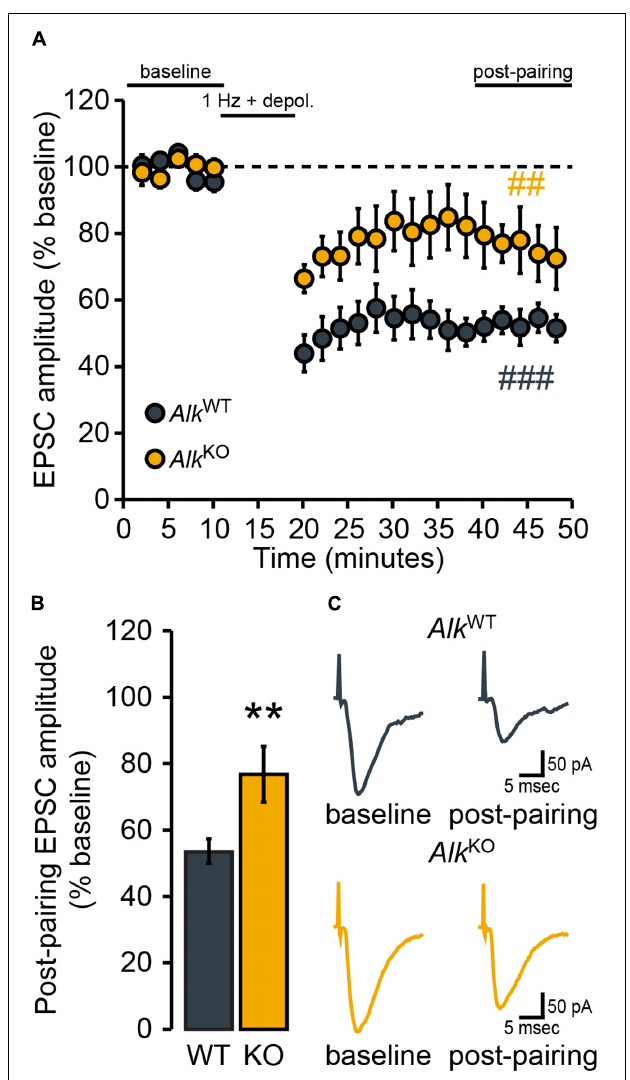
FIGURE 3 | NAcSh D1MSN LTD is attenuated in Alk KO mice. D1MSNs from Alk WT mice ( n = 5 cells, four mice) showed robust LTD of evoked EPSCs over the “post-pairing” period (40–50 min). In comparison, the magnitude of LTD expressed was markedly less in D1MSNs from Alk KO mice ( n = 6 cells, three mice). (A) Data points are group means ( ± SEM) for normalized (% baseline) EPSC amplitudes averaged over 2-min bins. ### p = 0.0001, post-pairing vs. baseline period (simple effect of pairing) in Alk WT . ## p = 0.007, post-pairing vs. baseline period (simple effect of pairing) in Alk KO . (B) Bars show group means ( ± SEM) for normalized EPSC amplitudes averaged over the entire 10-min post-pairing period. ∗∗ p = 0.004, Alk KO vs. Alk WT (simple effect of genotype during post-pairing period). (C) Representative traces of evoked EPSCs during the baseline and post-pairing